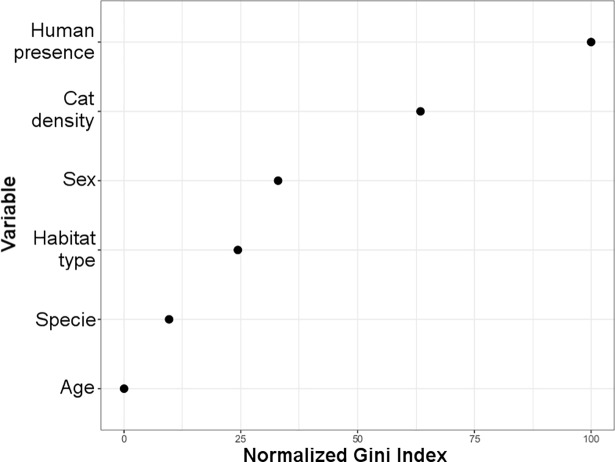
Variable importance analysis performed using random forest.The set of four categorical variables (age, species, habitat type, sex) and two continuous variables (human presence and cat density) used for classification the seropositivity to Toxoplasma gondii. Variables are ordered by their importance from top to bottom as estimated by the random forest model and denoted using an Gini index ranging from 0 to 100.